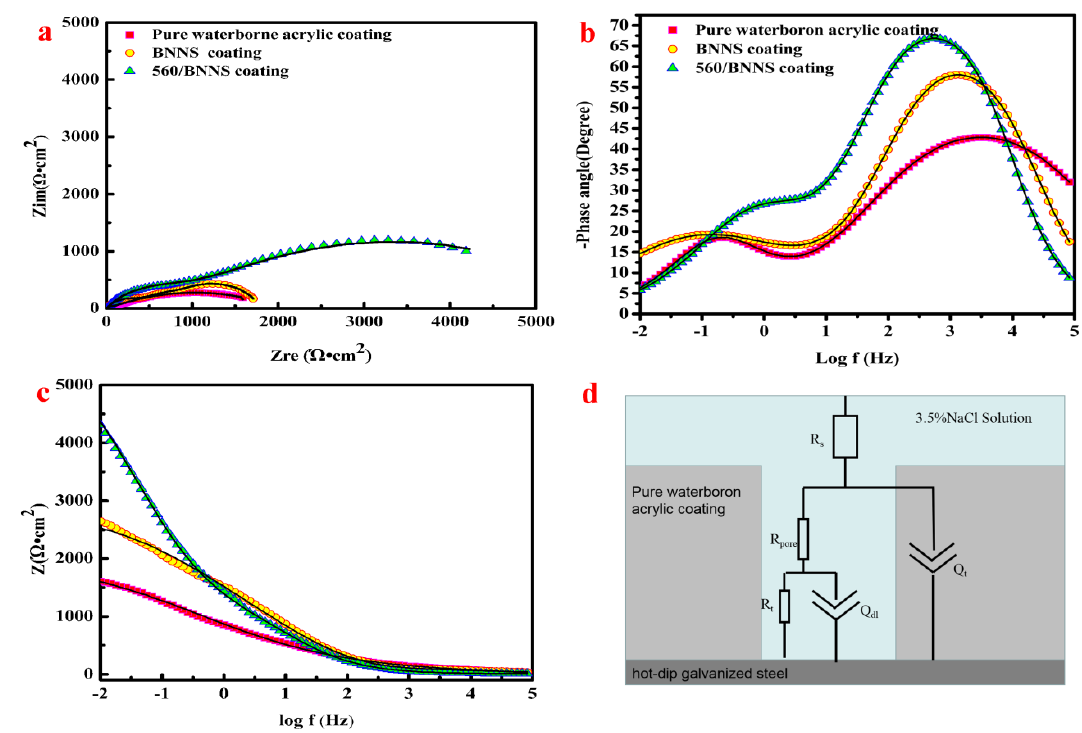
Figure 10. The EIS results of pure waterborne acrylic coating, BNNS coating and 560/BNNS coating. ( a ) is the Nyquist plot, ( b ) and ( c ) are the Bode plots, ( d ) is the equivalent electric circuit.